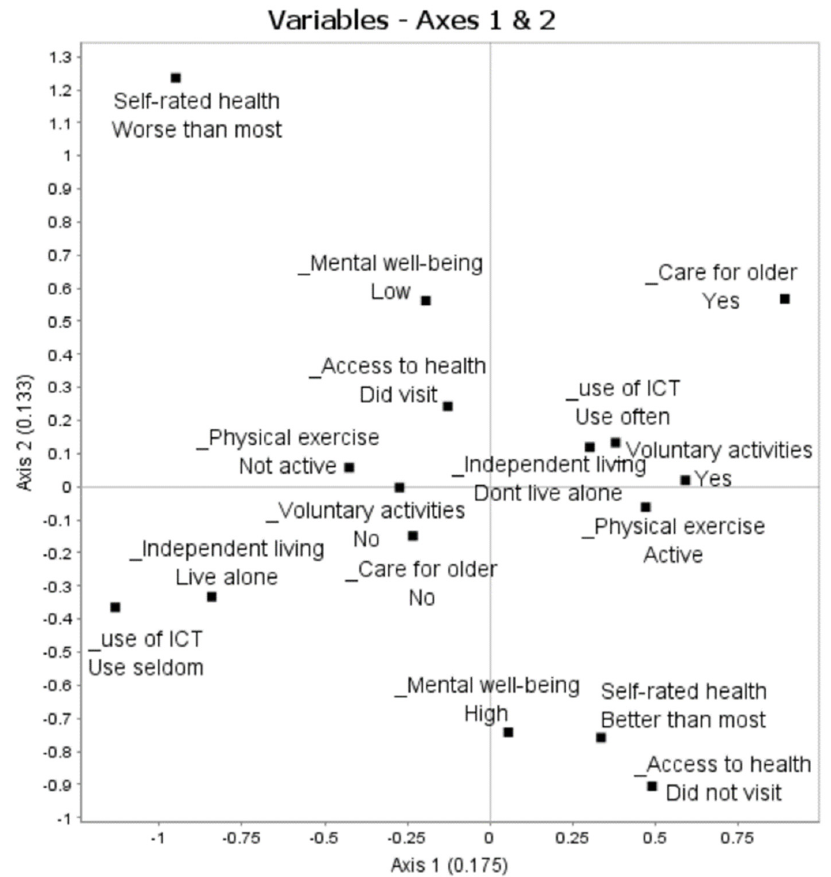
Table 2. Interpretation of Axis 1; 8 response categories contributing above-average to axis variance, 4 additional categories contributing below-average added in brackets. Ctr. of variables and categories are in percent.